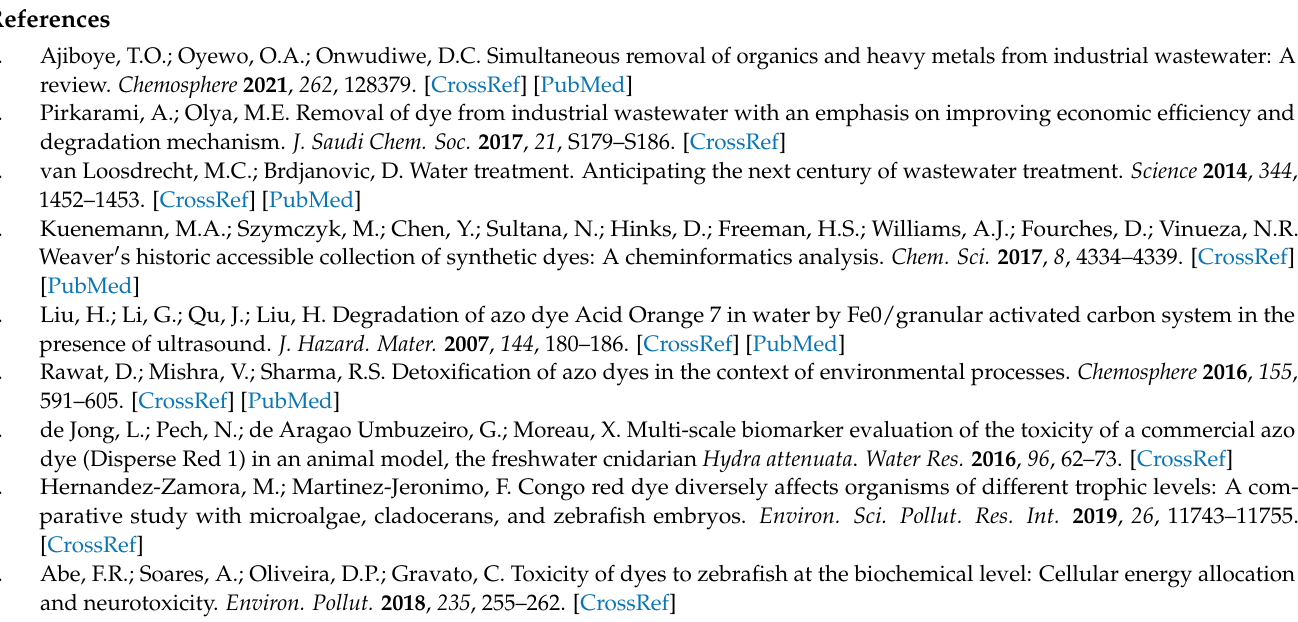
ized white cotton, and Ag NP cotton catalyst; Figure S2: XPS spectra of pristine white cotton and Ag NP cotton catalyst; Figure S3: UV/vis spectra and overlay of percent degradation of dyes for NaBH 4 control at pH 7; Figure S4: UV/vis spectra and overlay of percent degradation of dyes for NaBH 4 control at pH 9; Figure S5: Digital image of degradation reactions before and after for MO; Figure S6: Digital image of degradation reactions before and after for CR; Figure S7: Digital image of degradation reactions before and after for CSBB; Table S1: Comparison of degradation reaction conditions for this study and others similarly performed in the literature. References [26,46,50,51] are cited in the Supplementary